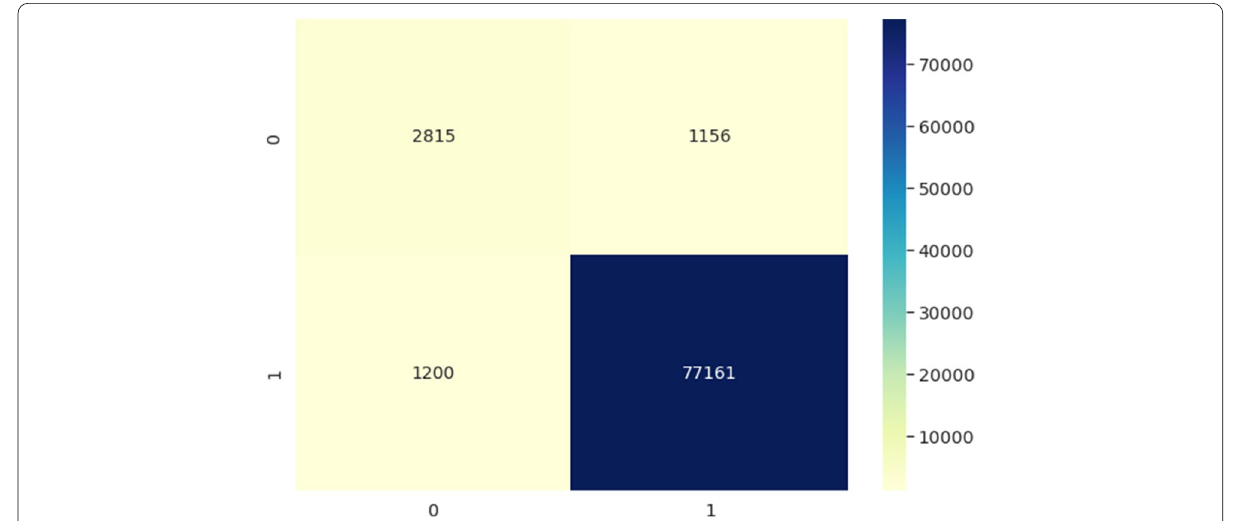
Fig. 4 Confusion Matrix of Machine Ensemble Model